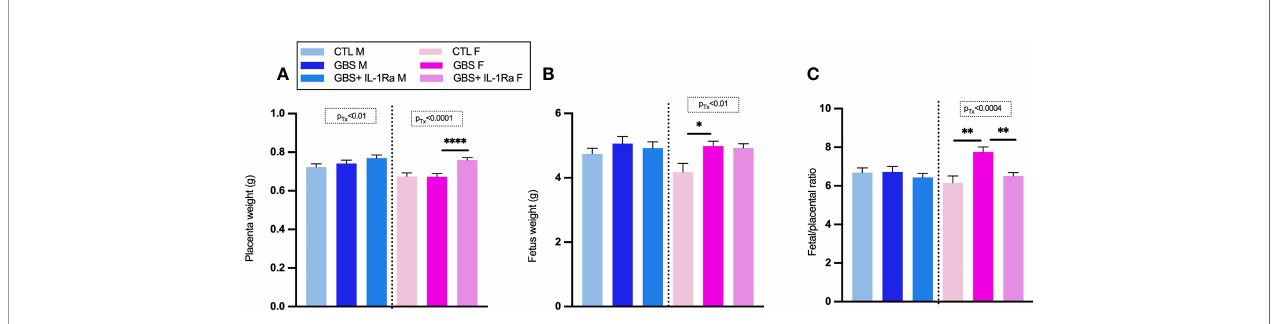
FIGURE 5 | Impact of IL-1Ra on fetal and placental weight in response to GBS infection. IL-1Ra positively controls the fetal and placental weight in response to GBS infection. Mean of placental weight (A) , fetus weight (B) and the ratio of fetus placenta at G22 (C) . Number (n) of placentas: CTL (male [n = 43), female (n = 23)], GBS [male (n = 38), female (n = 43)], and GBS plus IL-1Ra [male (n = 33), female (n = 32)]. Data were collected from four individual experiments. Analyses were done by ANOVA test separately for males and females with Dunnett ’ s multiple comparisons between groups (CTL, GBS, and GBS plus IL-1Ra) when treatment was signi fi cant. *p < 0.05, **p < 01, ****p ≤ 0.001 Bars show mean ± SEM. F, female; G, gestational day; GBS, group B Streptococcus; IL-1Ra, IL-1 receptor antagonist; M, male; SEM, standard error of the